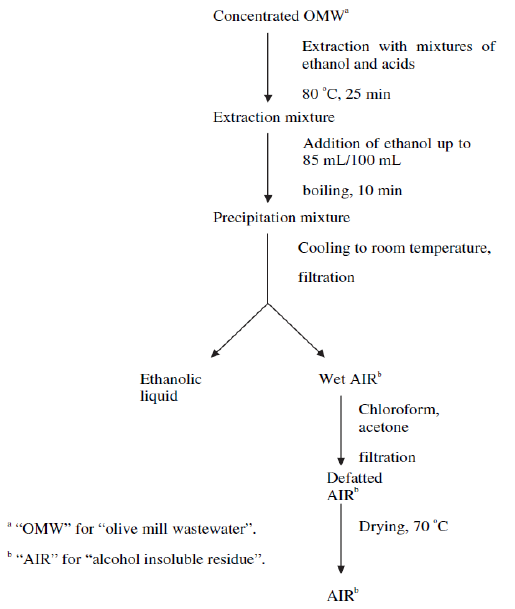
Figure 9. Process flow for the recovery of the AIR from OMW. Reprinted with permission from Reference [177]. Copyright 2010. Elsevier. Reference [177]. Copyright 2010.